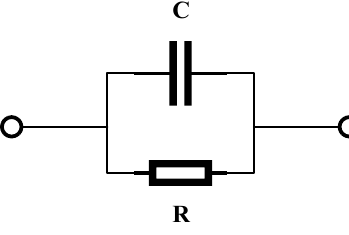
Figure 2. RC parallel circuit .